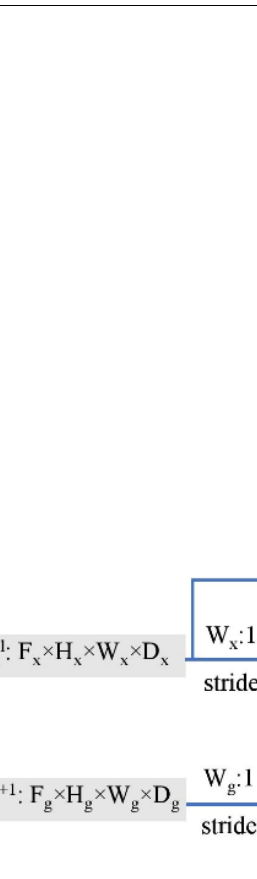
Figure 4. The attention gate schematic